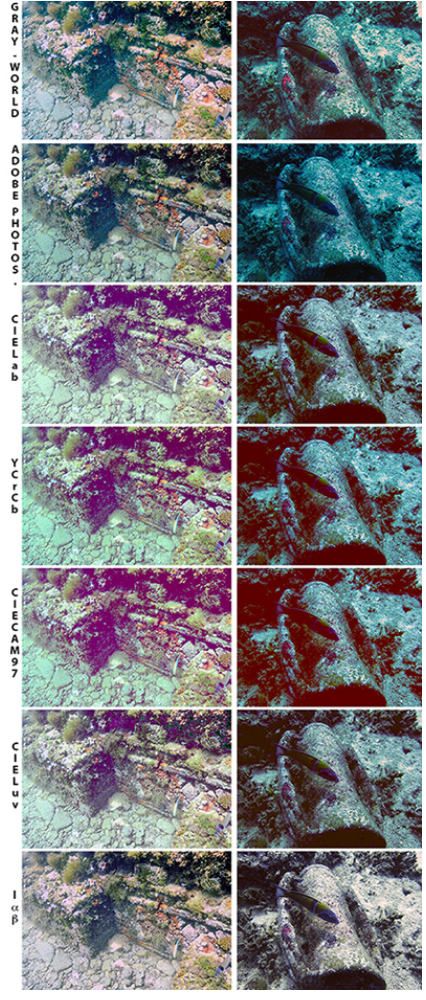
Figure 8: Comparison among different color correction